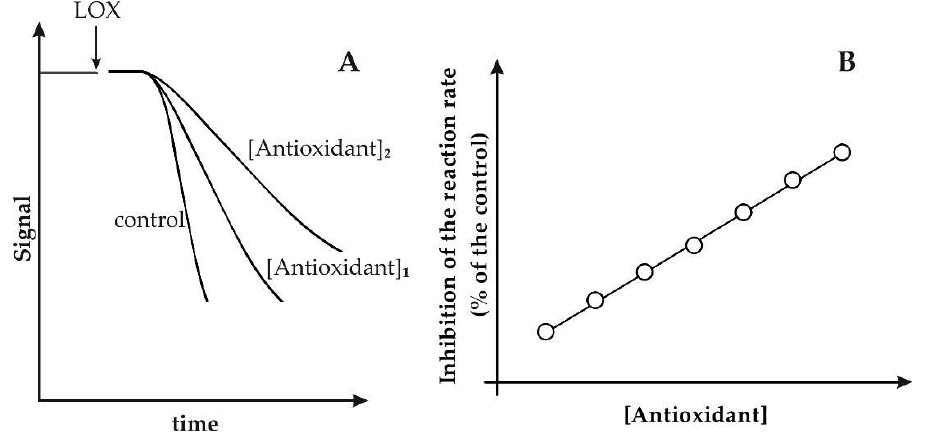
Figure 2. Inhibition of LOX/RNO (or LOX–FL) reaction by antioxidants. ( A ) Experimental traces relative to LOX/RNO (or LOX–FL) reactions measured in both the absence (control) and presence of two increasing concentrations of a generic antioxidant are shown. ( B ) The inhibition, expressed as (%) decrease of LOX/RNO (or LOX–FL) reaction rate with respect to the control, is reported as a function of antioxidant concentration.